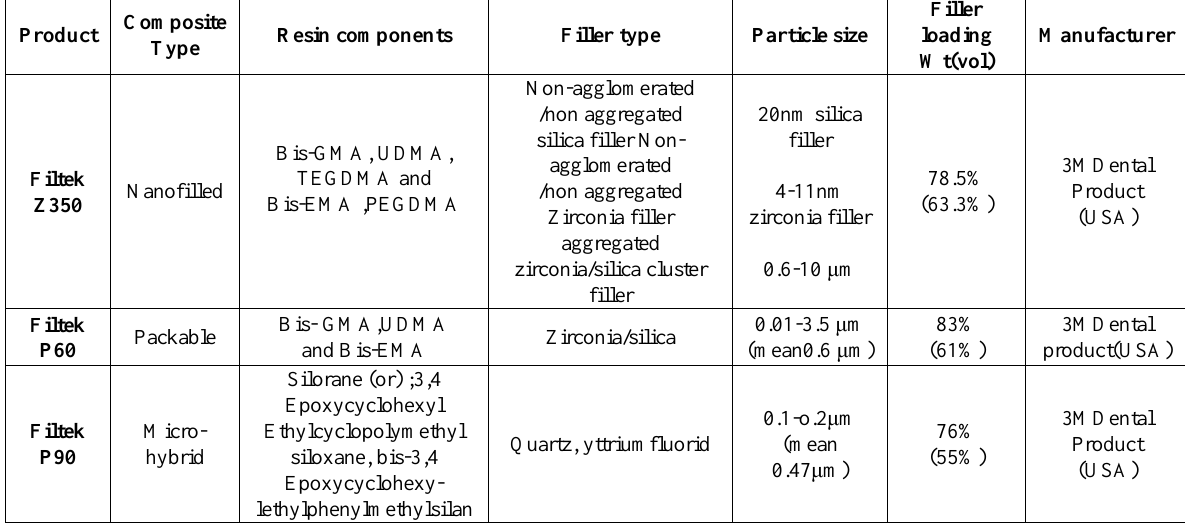
Table 1: Types of composite resin materials used in this study